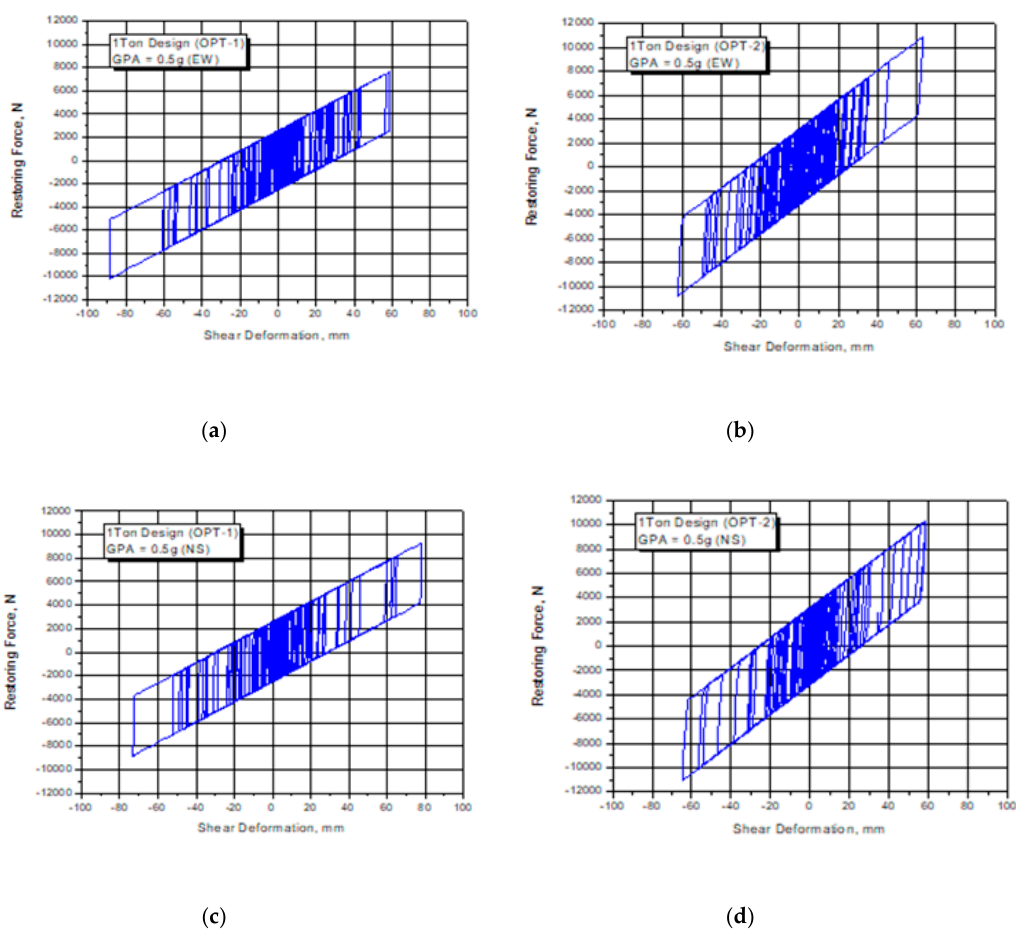
Figure 7. Hysteresis responses for PGA = 0.5g: ( a ) OPT-1 (EW); ( b ) OPT-2 (EW); ( c ) OPT-1 (NS); and ( d ) OPT-2 (NS).